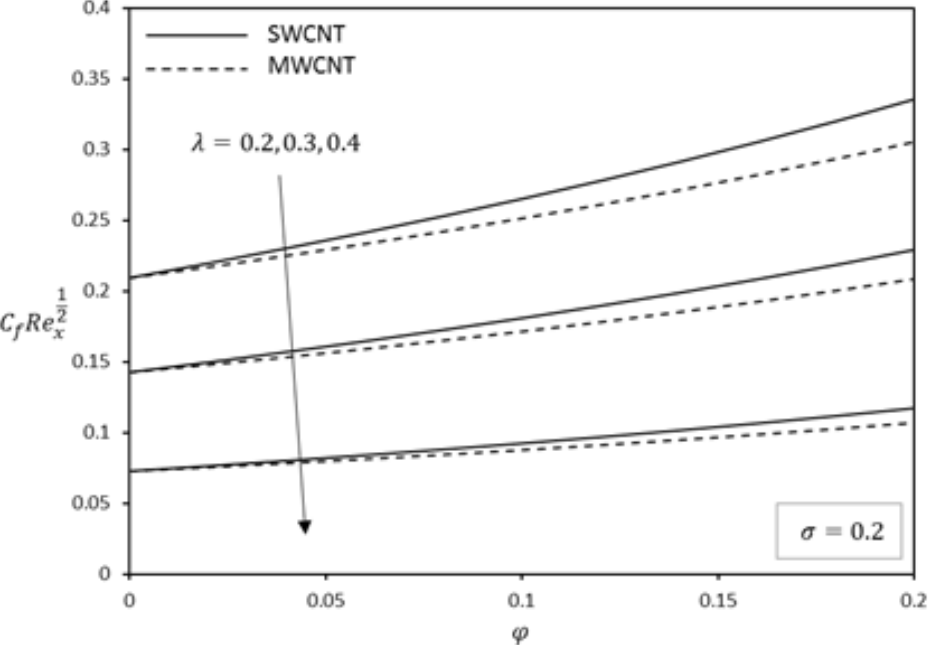
Figure 10. Effect of λ on skin friction for kerosene-based fluid.